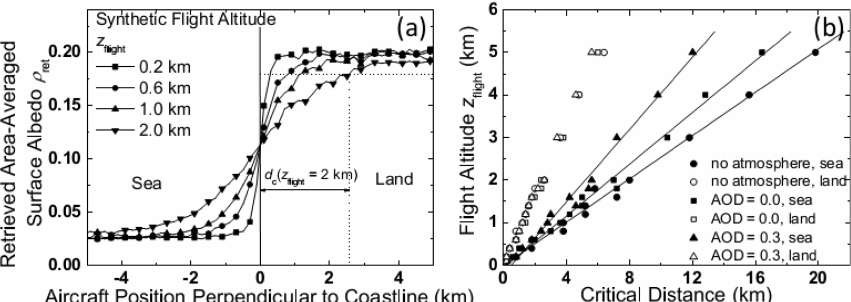
Fig. 2. (a) Cross-section of retrieved surface albedo ρ ret across the coastline (solar zenith angle θ 0 =30 ◦ , aerosol optical depth AOD=0.3, single scattering albedo ˜ ω =0.75, asymmetry parameter g =0.75). (b) Critical distance to coastline dependent on flight altitude ( θ 0 =30 ◦ , ˜ ω =0.75, g